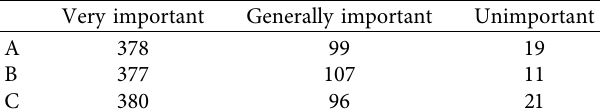
Table 1: Survey results of college physical education students’ awareness of the importance of innovation.